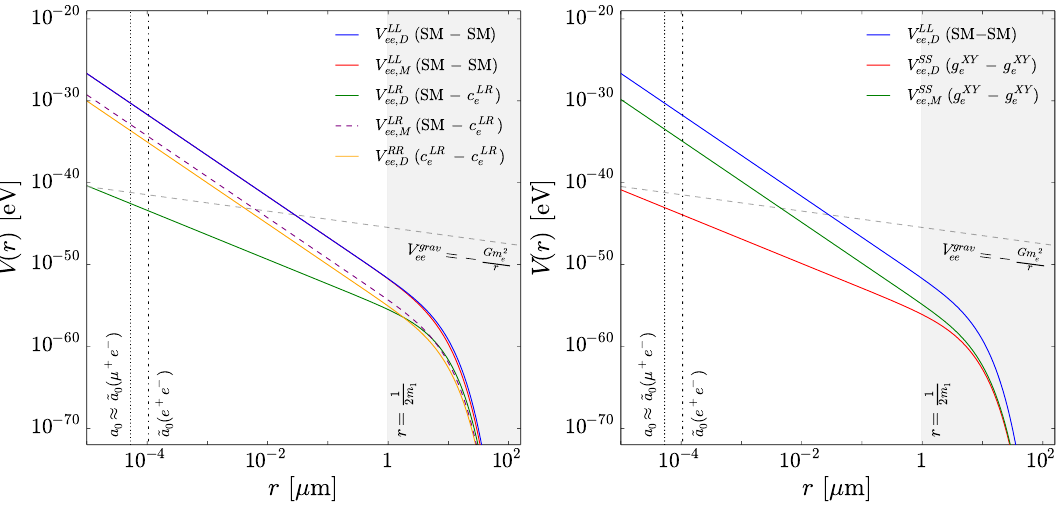
Figure 4 . Left : spin-independent parts of the potentials V LL ( r ), V LR ( r ) and V RR ( r ) plotted for (cid:11)(cid:12) (cid:11)(cid:12) (cid:11)(cid:12) positronium ( e (cid:0) e + ) and for the exchange of either three light active Dirac ( D ) or Majorana ( M ) neutrinos with m 1 = 0 : 1 eV and NO mixing parameters. V LL ( r ) is calculated with SM CC and NC ee interactions at each vertex, while V LR ( r ) and V RR ( r ) assume non-zero non-standard coe(cid:14)cients ee ee c LR (cid:17) c LR (cid:14) ij = 10 (cid:0) 2 (cid:14) ij . The solid (dashed) lines indicate a positive (negative) potentials. Right : e ee ; ij spin-independent parts of the potentials V SS ( r ) in the Dirac and Majorana cases compared ee